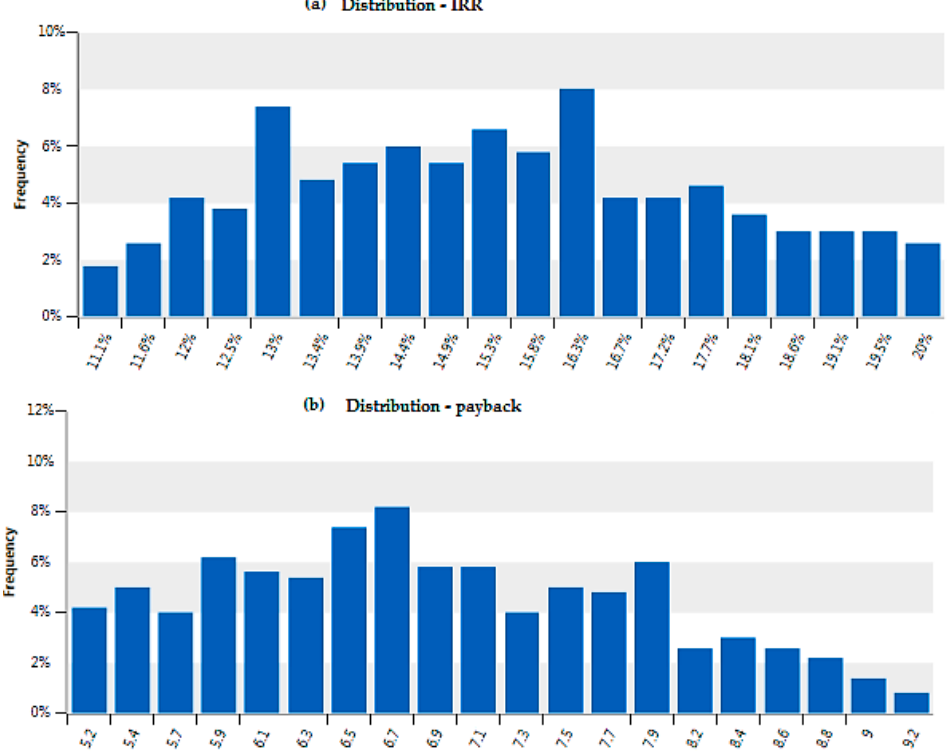
Figure 18. Risk distribution; ( a ) IRR (%), ( b ) payback (year).